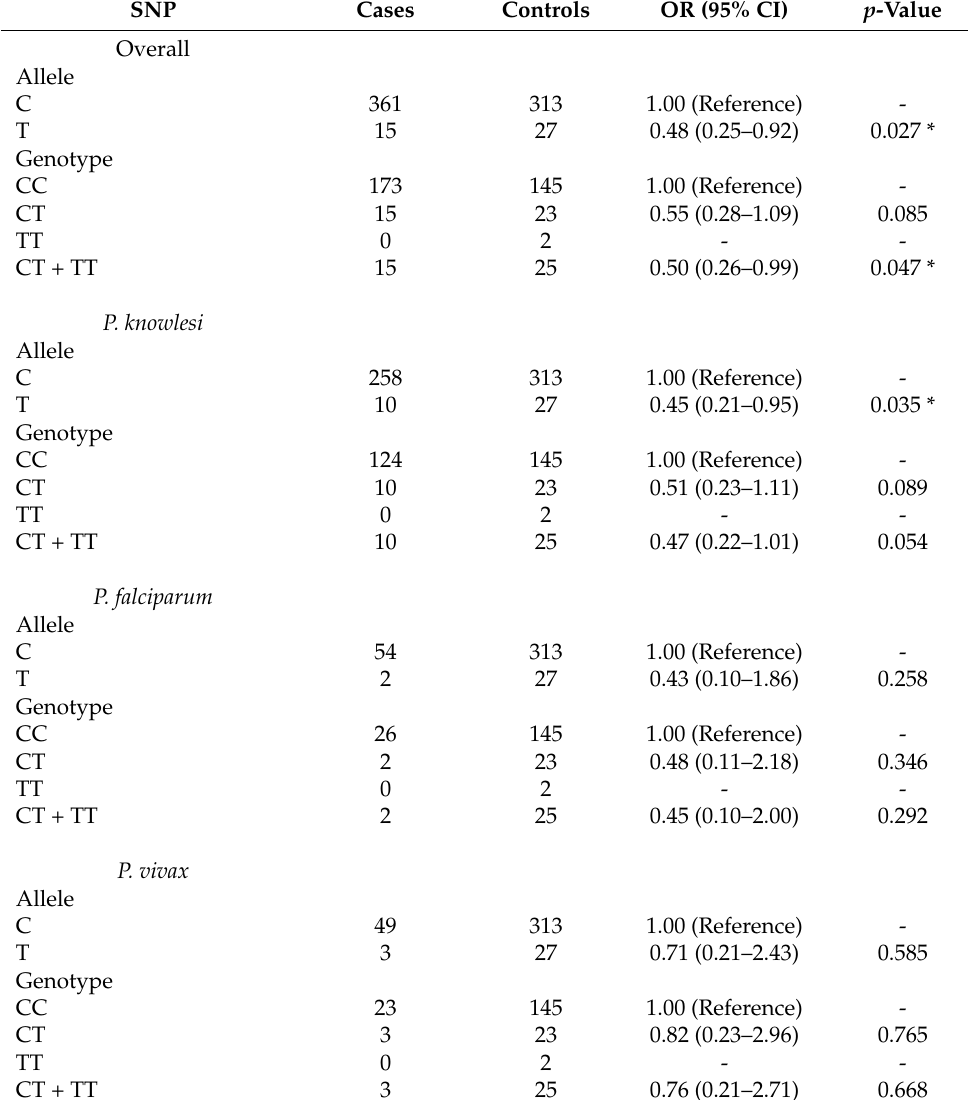
Table 2. Association of the β -like globin C-158T SNP with malaria risk.